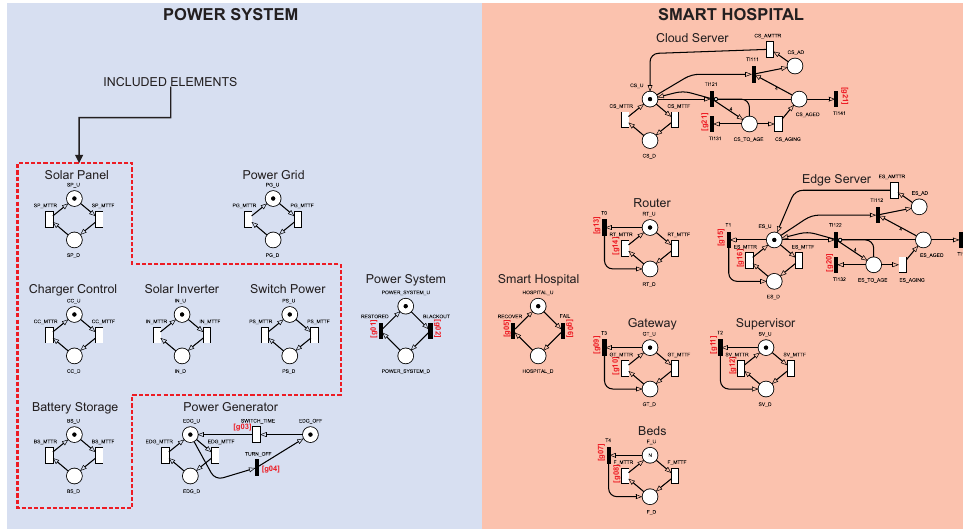
Figure 6. SPN model